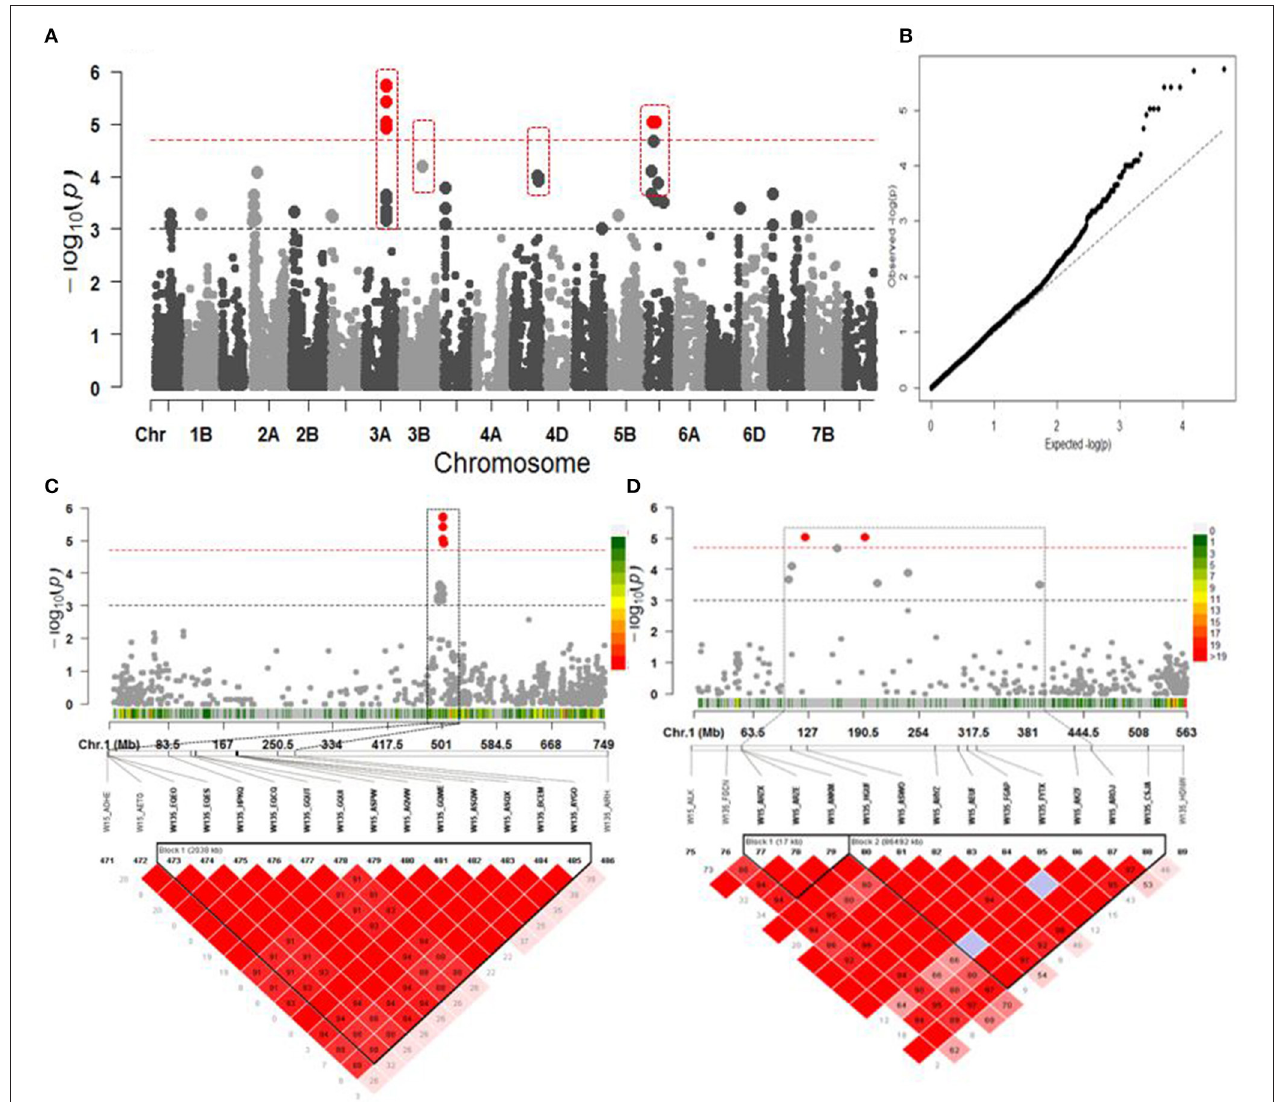
FIGURE 4 | Association mapping for year of release. (A) Manhattan plot from association mapping using the MLM. The top 13 SNPs are shown in gray or dark gray (bigger size circle) and the SNPs exceeding the significance threshold of Q 0.05 FDR correction are shown in red; the MTAs in dotted red squares are in common = with GSC. (B) QQ plot of expected and observed P -values. (C) The peak region on chromosome 3A span in a region of 0.643 Mbp from 502.398 to 503.027 Mbp harbored 6 MTAs in LD block. (D) The peak region on chromosome 5D spanning in a region of 15.58 Mbp size had two MTAs TA002565_0478 and wsnp_Ex_rep_c67164_65655648 in the first block, while the second block of 86.492 Mbp size comprised three MTAs wsnp_Ex_c65985_64188864, wsnp_Ku_rep_c72922_72561803, and Excalibur_c10046_579. In (C,D) , pair-wise LD between SNP markers is indicated as r 2 -values: dark red indicates a value of 1 and white indicates 0. The dotted squares in (C,D) denote the linkage blocks that contain high significant SNPs on 3A and 5D. The color scaled legends at the right side of the Manhattans plots in (C,D) indicate the SNP density in a chromosomal